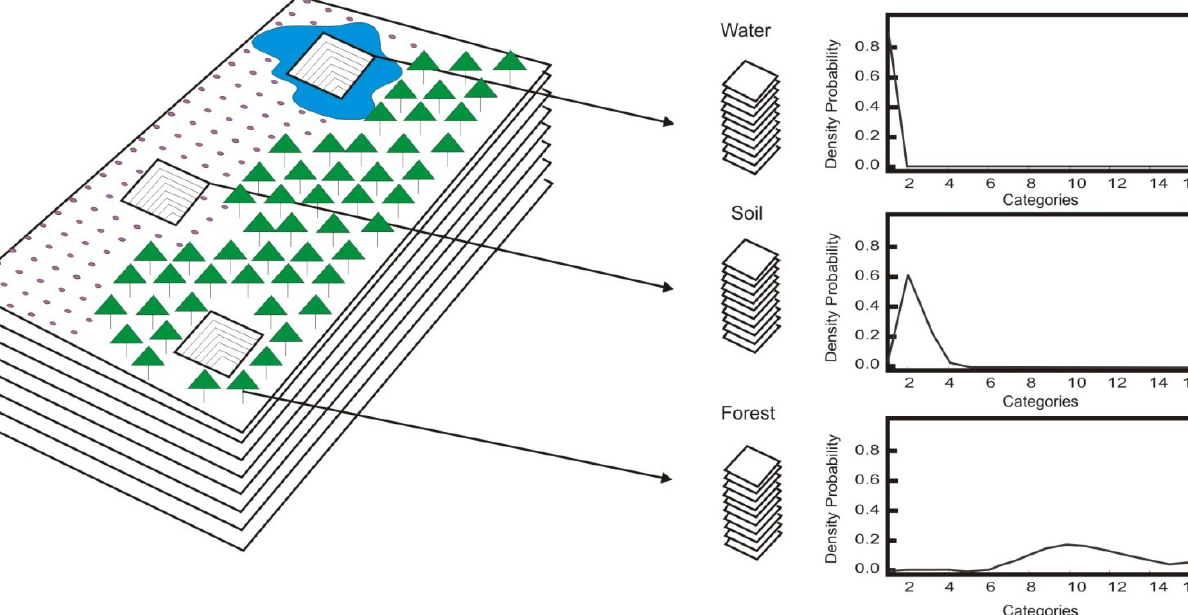
Figure 3. The concept of probability density component analysis is shown with a spectrum calculated for each spatial element in an image. The curve describe different